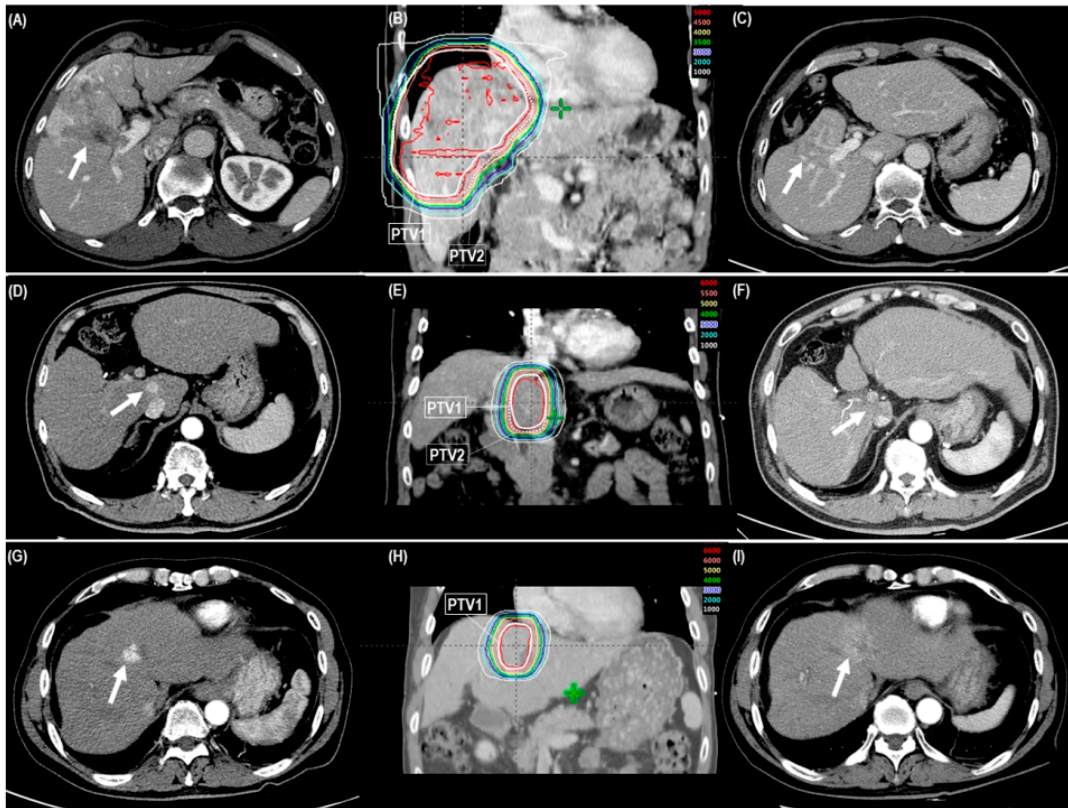
Figure 1. The cases showing objective tumor response after risk-adapted proton beam therapy (PBT) with three dose-fractionation regimens (regimen A, B, and C) according to the proximity of the gastrointestinal organs (<1 cm [ A – C ], 1–1.9 cm [ D – F ], and ≥ 2 cm [ G – I ], respectively). A , D , and G : Pre-treatment computed tomography (CT) scans showing the primary tumor and/or tumor vascular thrombosis (TVT) (arrow). B , E , and H : The patient received risk-adapted PBT (50 GyE, 60 GyE, and 66 GyE in 10 fractions to PTV1, respectively, and 30 GyE in 10 fractions to PTV2). C , F , and I : One-year follow-up CT scans after risk-adapted PBT showing notable reductions of the primary tumor and/or TVT (arrow). Abbreviations: PTV, planning target volume.